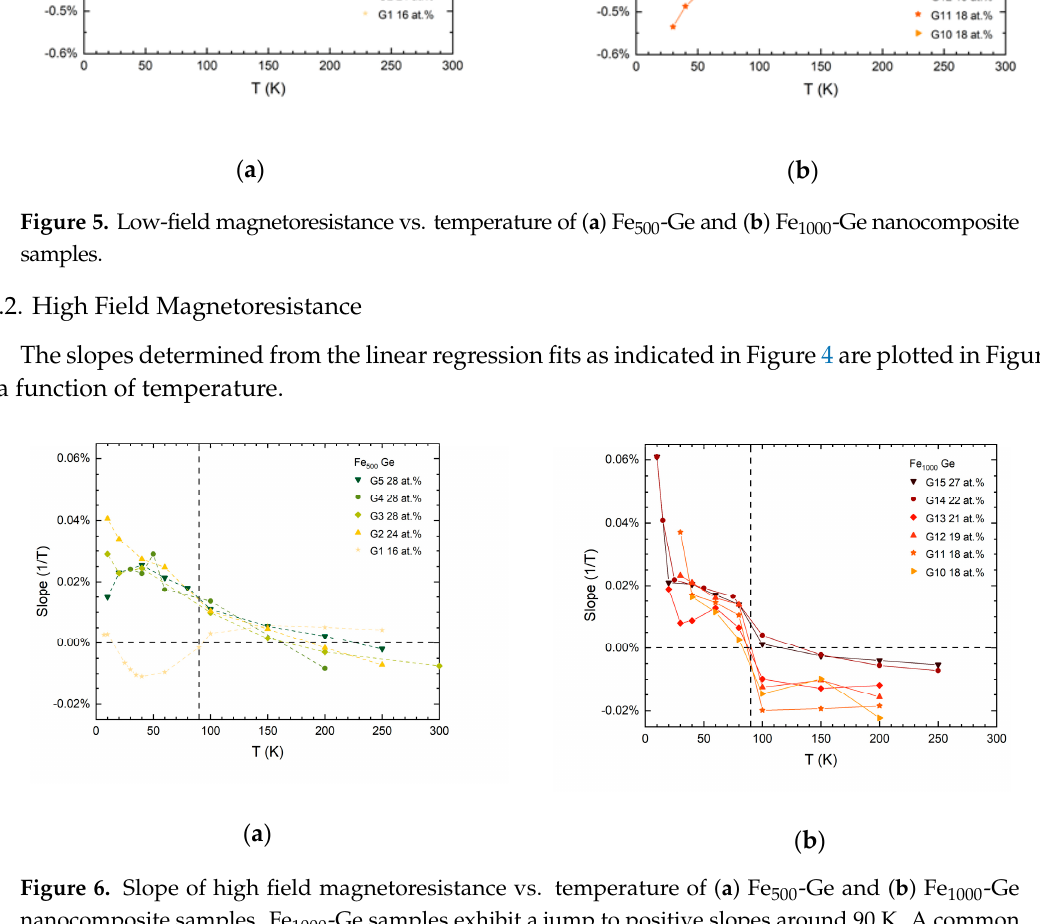
Figure 5. Low-field magnetoresistance vs. temperature of ( a ) Fe 500 -Ge and ( b ) Fe 1000 -Ge nanocomposite samples.